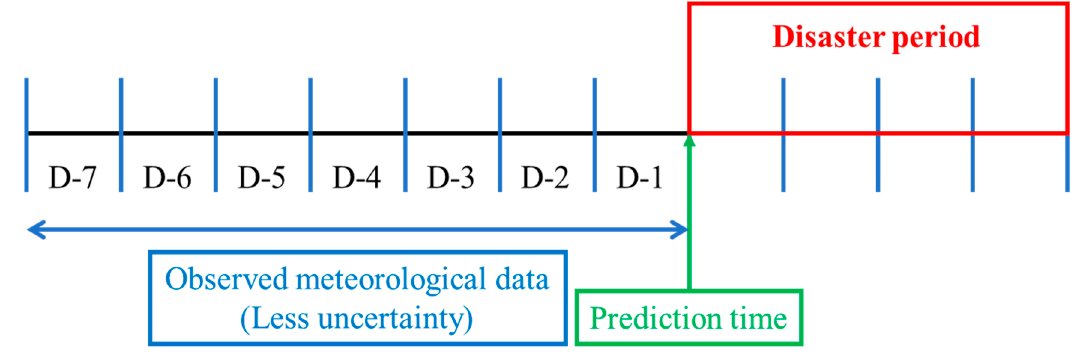
Figure 4. Composition of independent variables.